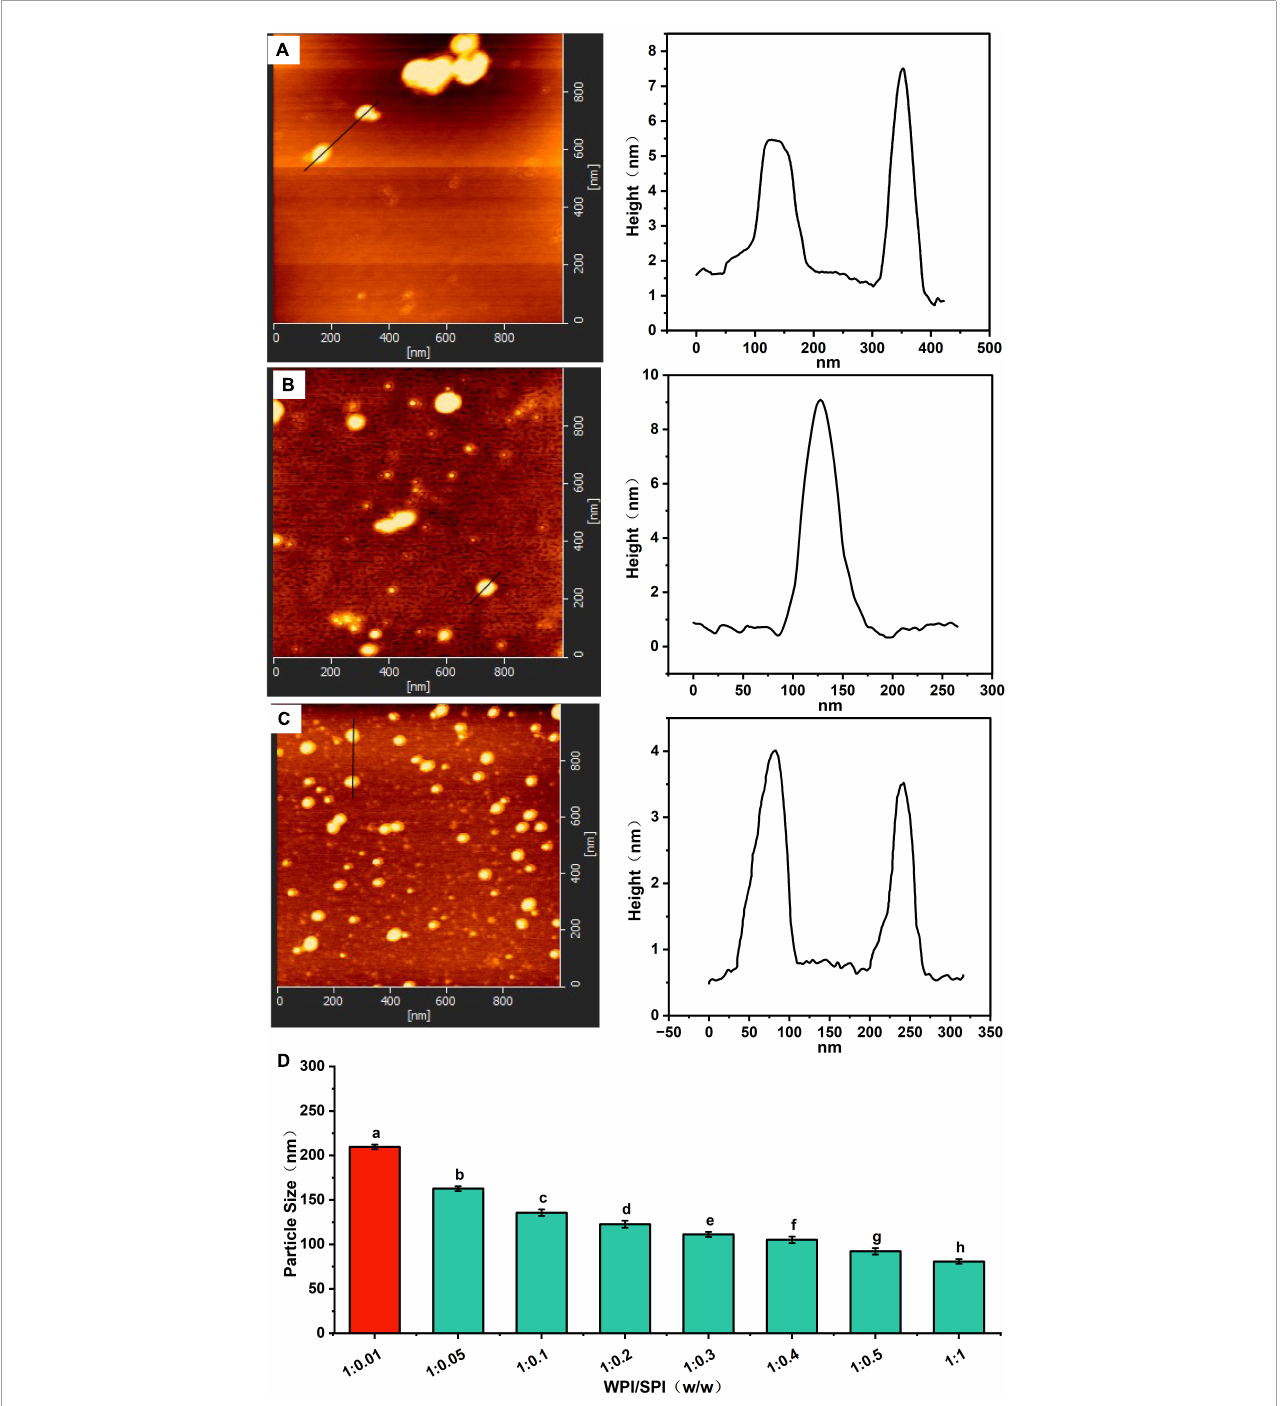
FIGURE4 (A) Atomic force microscopy (AFM) image of composite nanoparticles prepared by WPI: SPI (w/w) mass ratio of 1: 0.1. (B) AFM image of composite nanoparticles prepared by WPI: SPI (w/w) mass ratio of 1: 0.5. (C) AFM image of composite nanoparticles prepared by WPI: SPI (w/w) mass ratio of 1: 1. (D) Particle size of composite nanoparticles with WPI: SPI (w/w) from 1:0.01 to